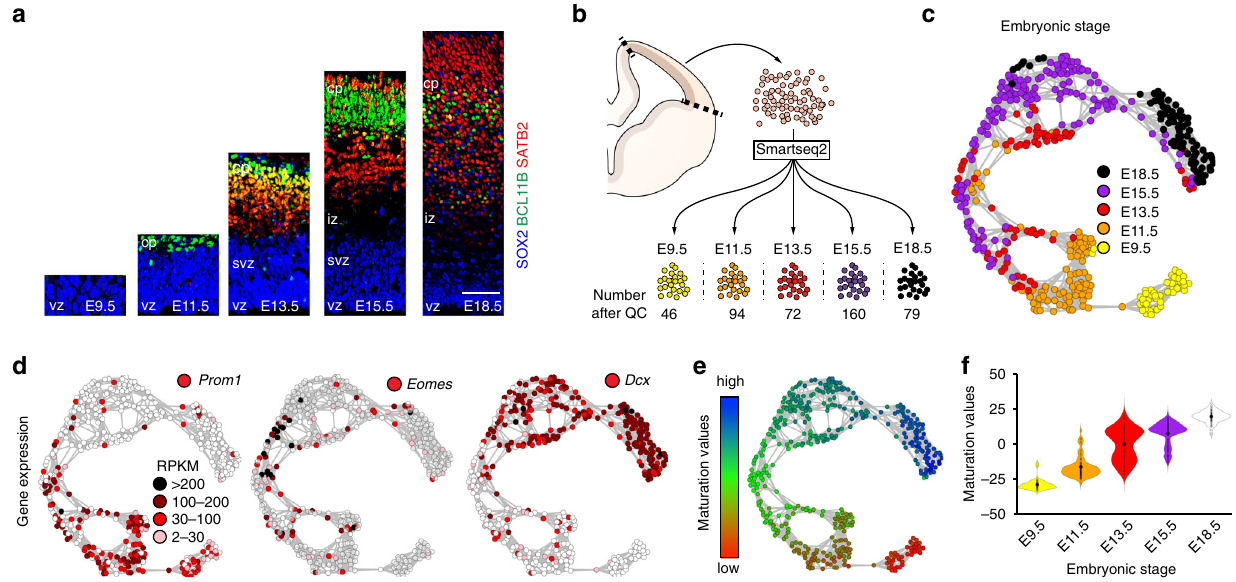
Fig. 1 Single-cell RNA-seq reveals a cortical maturation axis. a Immunohistochemistry shows expression of the progenitor markers SOX2, the deep-layer marker BCL11B and the upper-layer marker SATB2 in E9.5 to E18.5 cortices. Immunohistochemistry shown in ( a ) was repeated three times. b Experimental design for single-cell RNA-seq Smartseq2 analysis of cortical development. Number of cells sequenced; E9.5, 71; E11.5, 96; E13.5, 76; E15.5, 190; E18.5, 116. c t SNE-NN map of cortical cells passing quality control cell fi ltering. E9.5 (yellow), E11.5 (orange), E13.5 (red), E15.5 (purple) and E18.5 (black). d t SNE-NN maps show Prom1, Eomes and Dcx expression levels in the sequenced cells. e t SNE-NN map coloured by maturation values of sequenced cells, where red is low and blue is high. f Violin plots show the distribution of maturation-stage values for the cells sequenced from each embryonic age. These are inset by rings corresponding to the individual data points, a fi lled dot at the group mean and a vertical line showing standard error. Scale bar in ( a ) represents 24 µ m E9.5, 30 µ m, 36 µ m E11.5, E15.5 and 54 µ m E18.5. vz ventricular zone, svz subventricular zone, iz intermediate zone, cp cortical